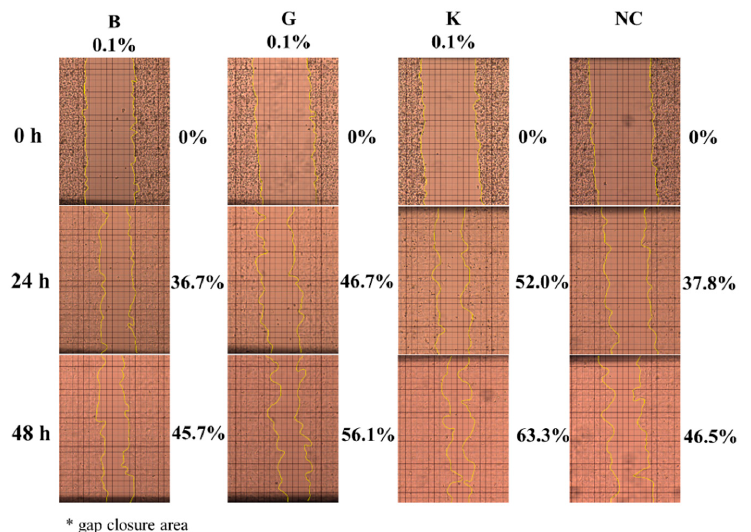
Figure 4. HaCaT cells migration investigated by in vitro wound scratch assay using HA-B (8 kDa), -G (987 kDa) and -K (2290 kDa) at different time points. Representative images of HaCaT cells monolayer with scratch after culturing for 0, 24 and 48-h with/without 0.1% HA at three different